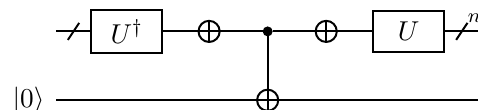
Figure 4. The circuit to implement eq. (6.21), where P = U | 0 . . . 0 ih 0 . . . 0 | U † . Here U is a general unitary matrix acting on n qubits and the gate in the middle is a multi-qubit Toffoli gate controlled on n qubits. The NOT gates are applied to all the n